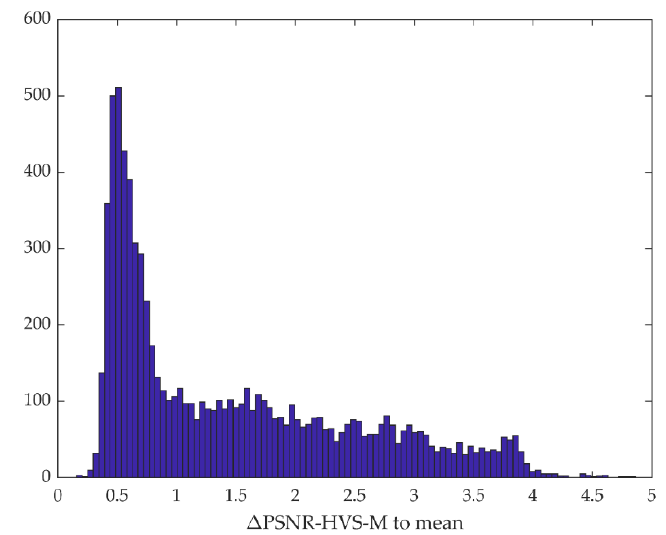
∆ PSNR-HVS-M for test Figure 9. Histogram of ∆PSNR-HVS-M for test images. Figure 9. Histogram of